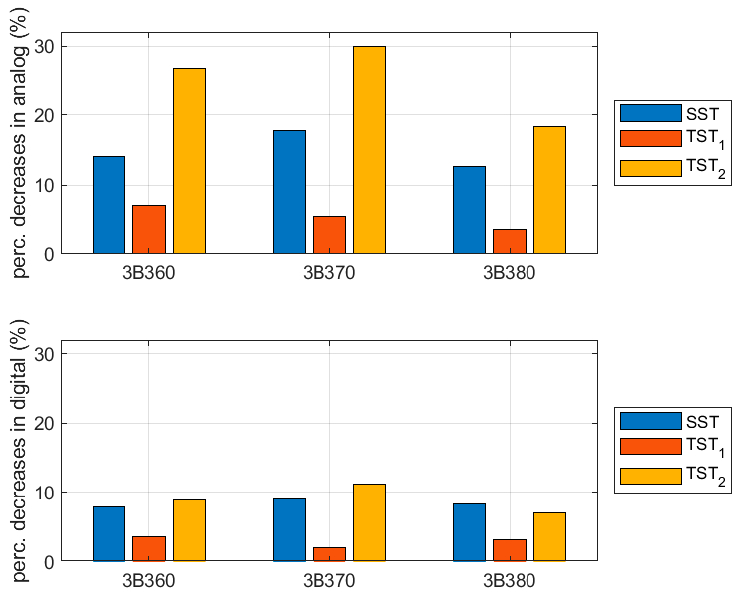
Figure 10. Bar plots of percentage differences between results for crease-free region samples and